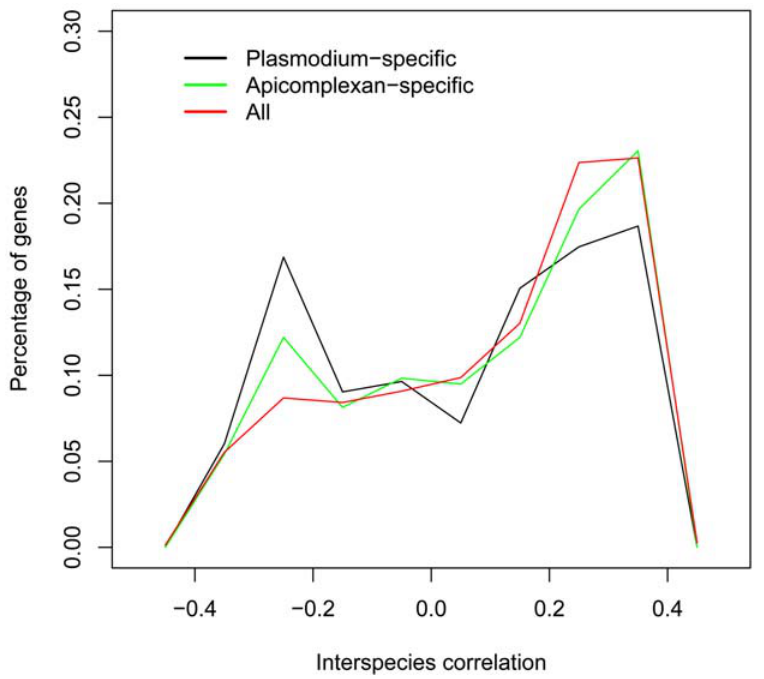
Figure 9. Plasmodium -specific genes are more likely to be diverged in expression. Comparison of interspecies correlations of all genes to that of apicomplexan- and Plasmodium -specific genes suggests that phyletically-restricted sets of genes are more likely to be diverged in expression. The distribution of all genes is shown in red (n=760), that of apicomplexan-specific genes in green (n=295) and that of Plasmodium -specific genes in black (n=166). doi:10.1371/journal.pone.0003122.g009 PLoS ONE |